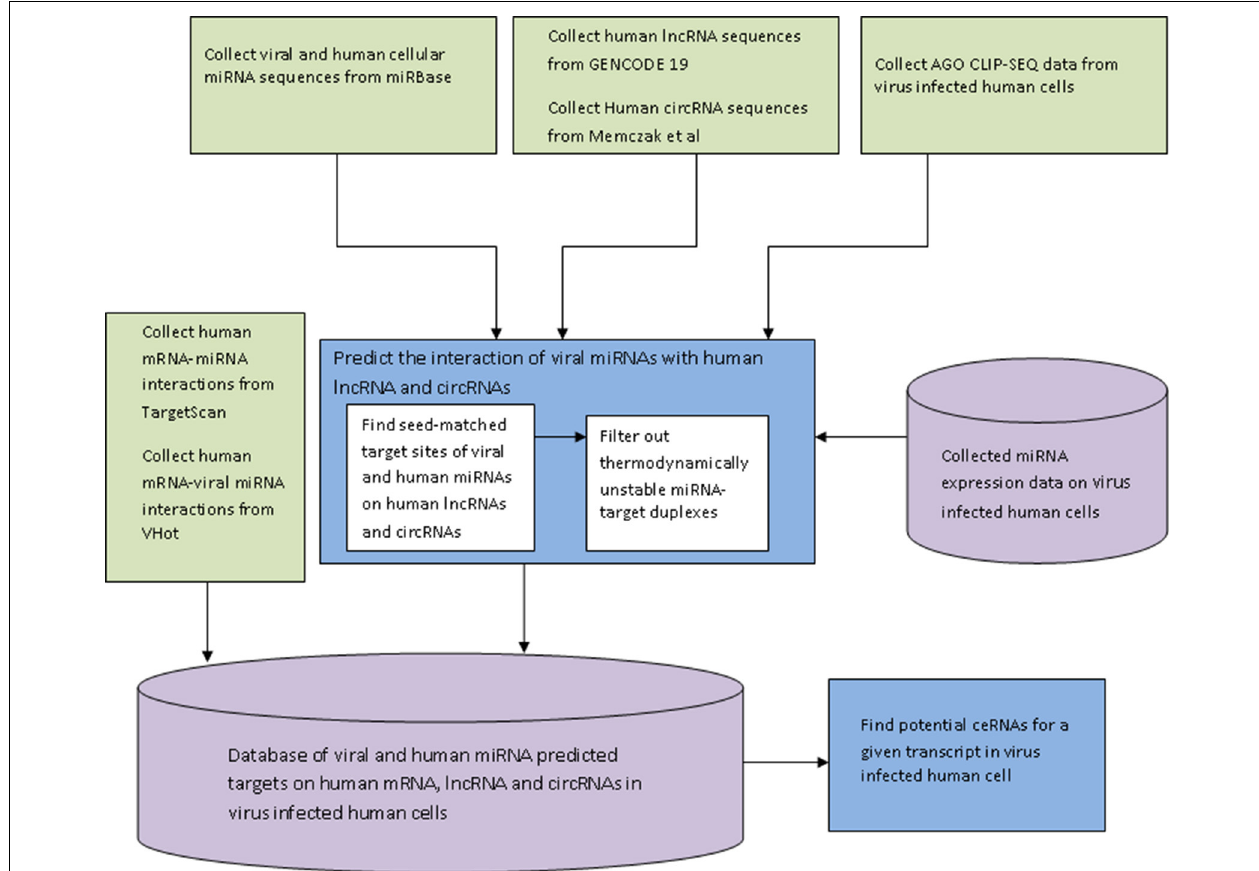
FIGURE 1 | The flow-diagram of the steps involved in development of the database HumanViCe. The predicted interaction of the host miRNA-host target and viral miRNA-host target was collected from Targetscan and VHot databases respectively. The interaction of host lncRNA and circRNA with viral miRNA was predicted by our custom algorithm. We also stored the miRNA